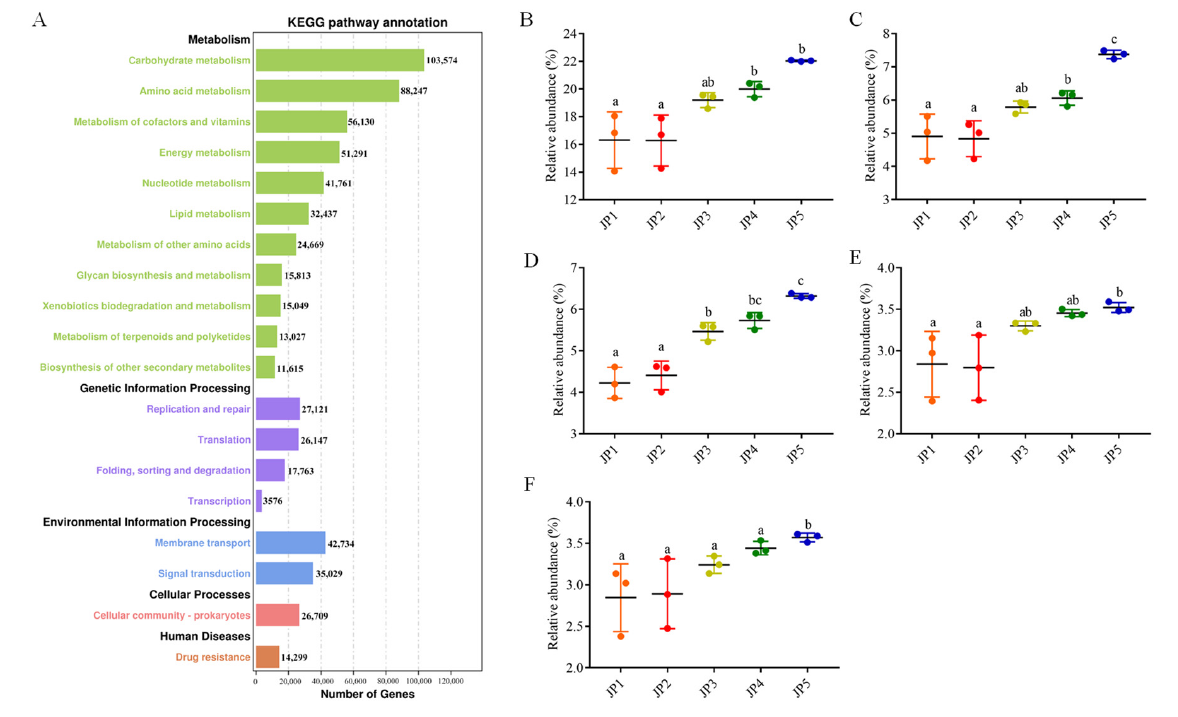
Figure 5. Differences in the KEGG function of all sampling sites. ( A ) KEGG function annotation of unigenes for metagenome sequencing of Jingpo Lake. Comparison of the abundance of microbial KEGG function among five different regions of Jingpo Lake. ( B ) Metabolism; ( C ) carbohydrate metabolism; ( D ) amino acid metabolism; ( E ) metabolism of cofactors and vitamins; ( F ) energy metabolism. Color scale represents the row-scaled, log-transformed relative abundances of function. Statistical analyses of alpha diversity were performed using Kruskal − Wallis test. a,b,c Bars marked with different letters indicate significant differences ( p < 0.05).